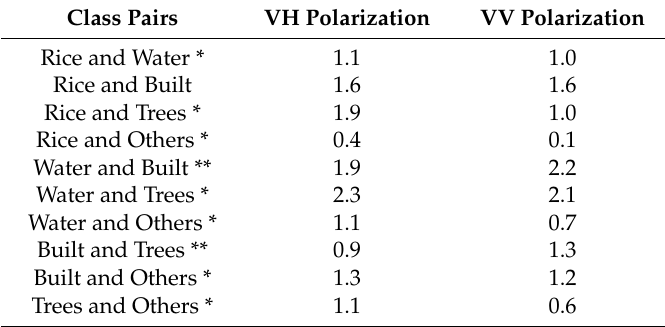
Table 4. Comparison of two-class separability results at VH and VV polarizations.